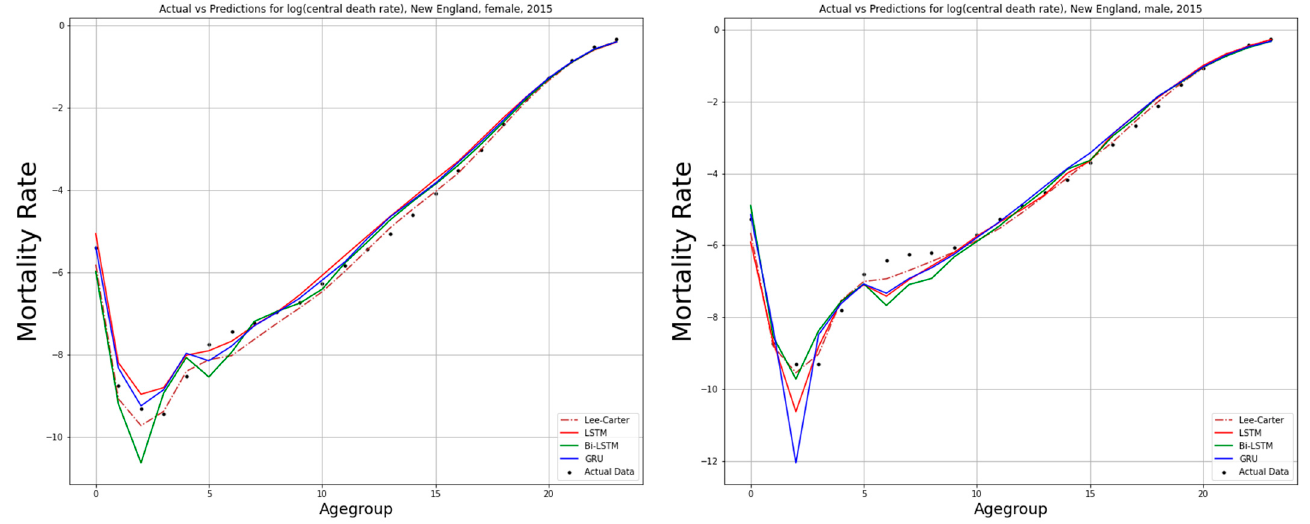
Figure 9. The predictions of the log-mortality rate for New England female ( left ) and male ( right ), 2015.